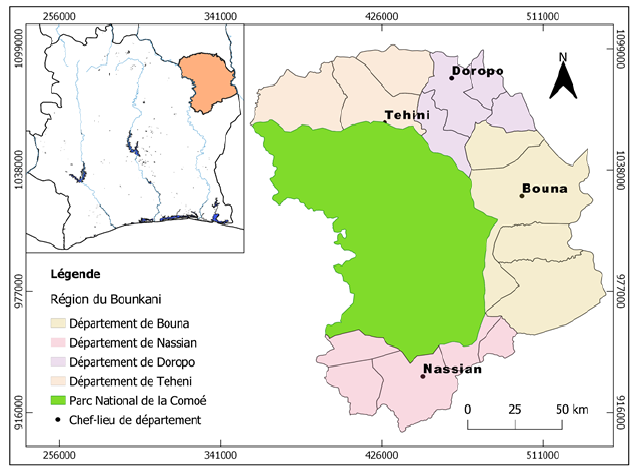
Figure 1: Location map of the study area (SOURCE: Prepared by authors in QGIS v